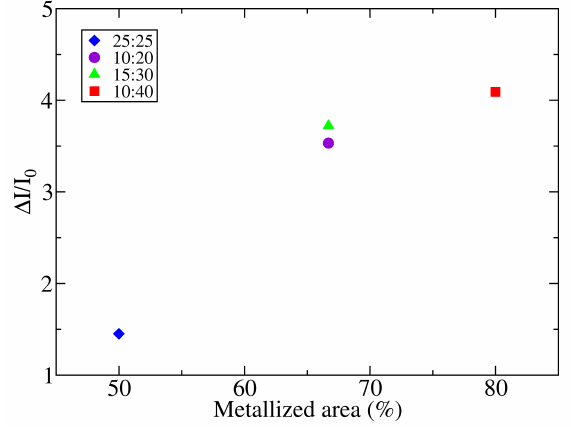
Figure 6. The photocurrent ( ∆ I the